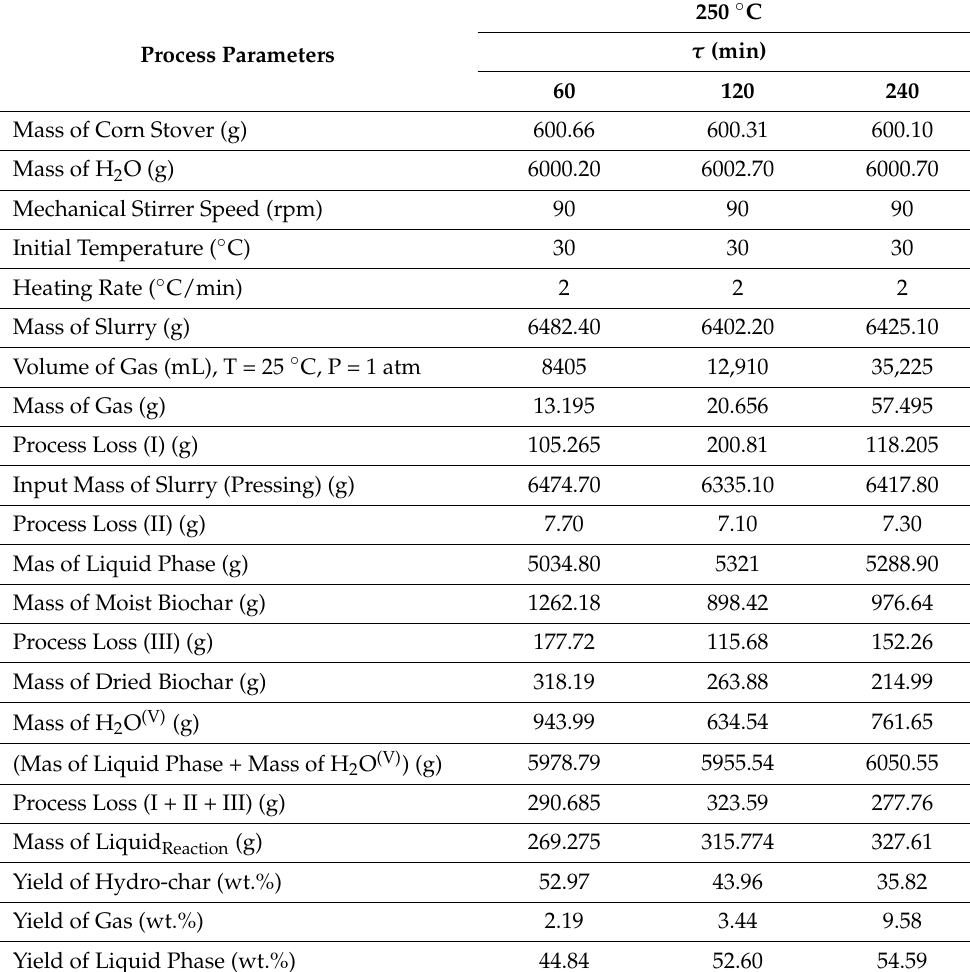
Table 4. Process parameters, mass balances and yields of reaction products by the hydrothermal carbonization of corn stover at 250 ◦ C with a biomass/H 2 O proportion of 1:10 after 60, 120 and 240 min using a reactor of 18.75 L.